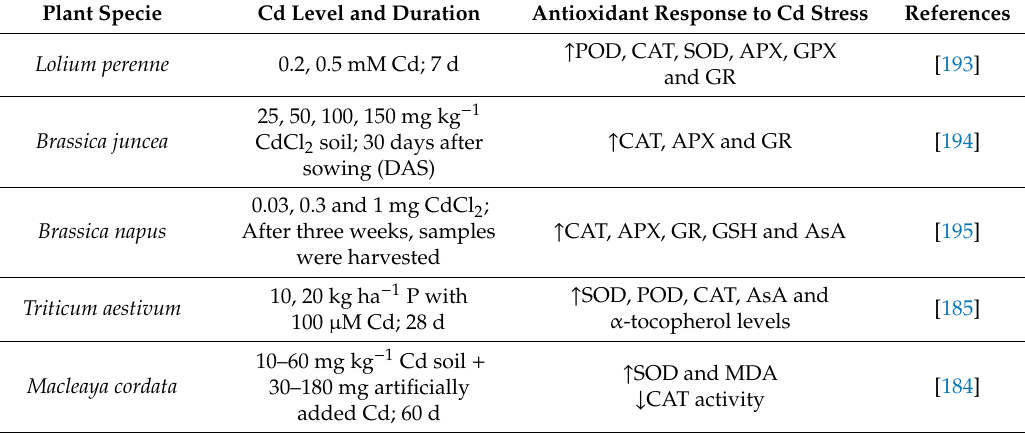
Table 3. Summary of experiments showing the potential of the antioxidant defense system as a key mechanism of cadmium tolerance and phytoremediation. Abbreviations are explained in the